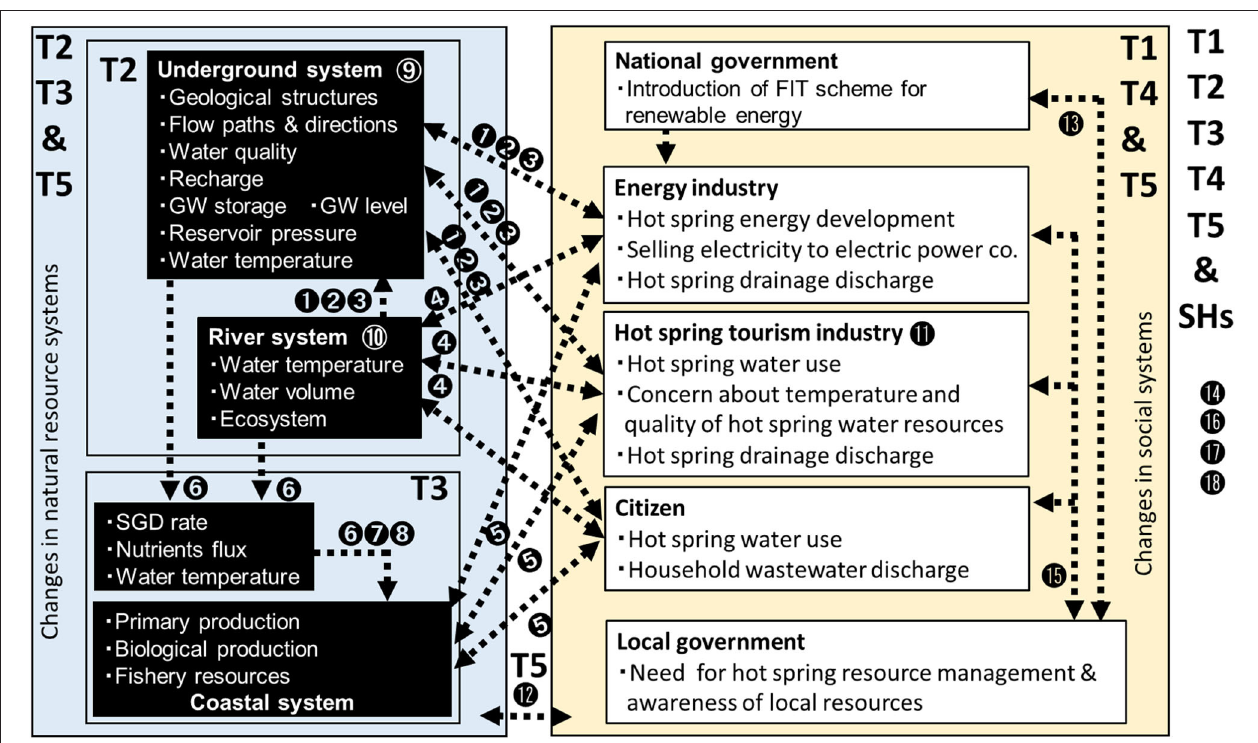
FIGURE 3 | Targeted natural and social systems, and targeted boundary of the five teams (T1–T5) in Beppu, Japan. Arrows demonstrate the causal linkages, while the numbers ( 1 - 18 ) indicate the methods applied and outputs in Beppu in Table 1 . GW, groundwater; SGD, submarine groundwater discharge; FIT, feed-in tariff; SHs,